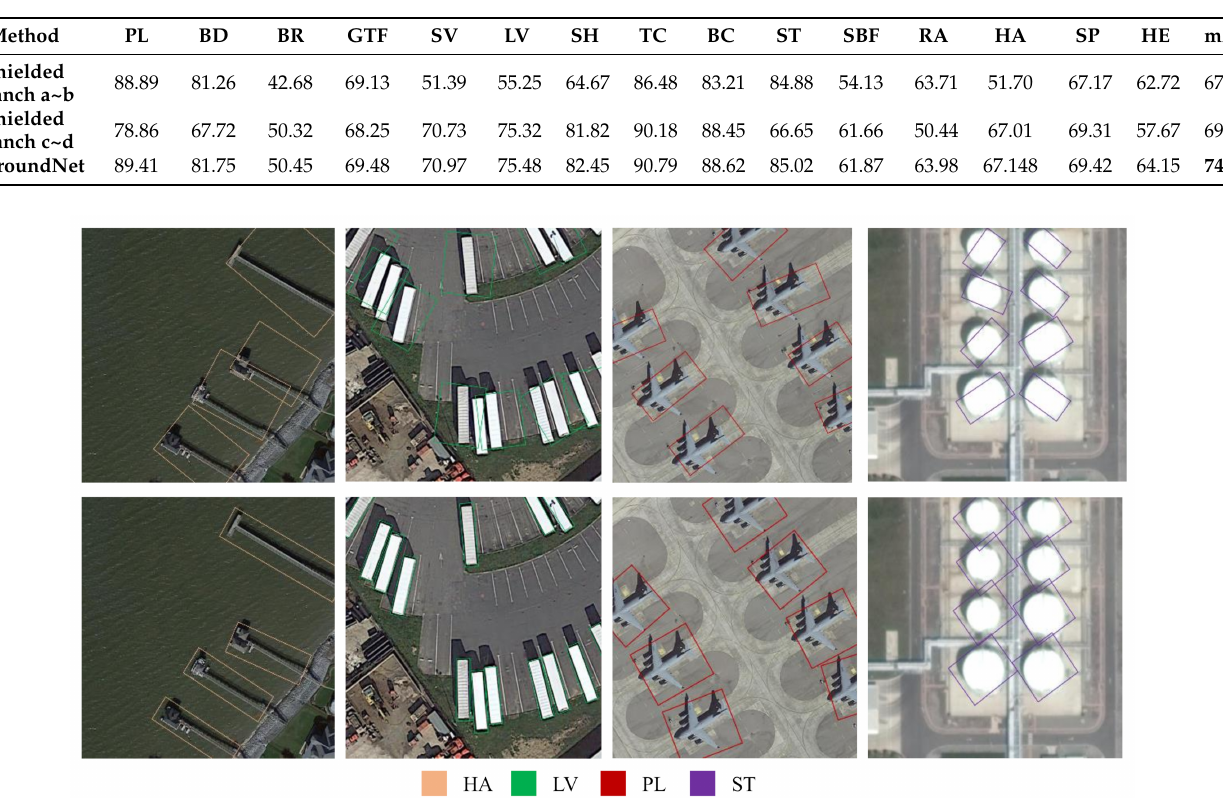
Figure 15. Visual results comparison of shielding regression